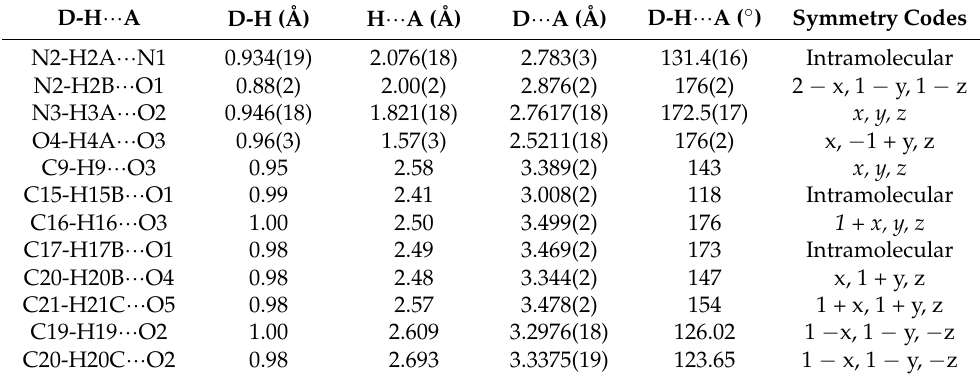
Table 2. Geometrical parameters of the hydrogen bond interaction in DPA:TA